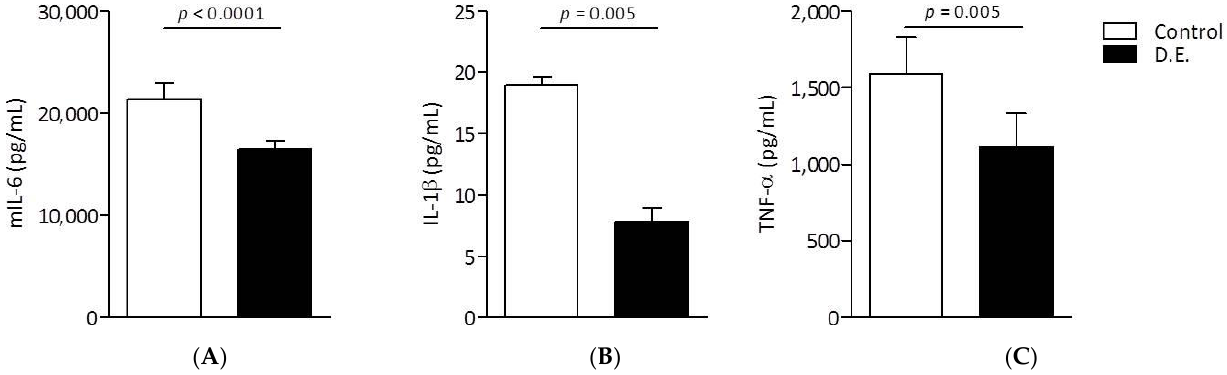
Figure 9. RAW 264.7 cells were in vitro co-treated with LPS (Control) and D.E. at 0.038 mg/mL for 24 h. Supernatants were collected and the concentrations of IL-6 ( A ), IL-1β ( B ) and TNFα ( C ) were determined by ELISA test. D.E. vs. Control (unpaired Student’s t -test).